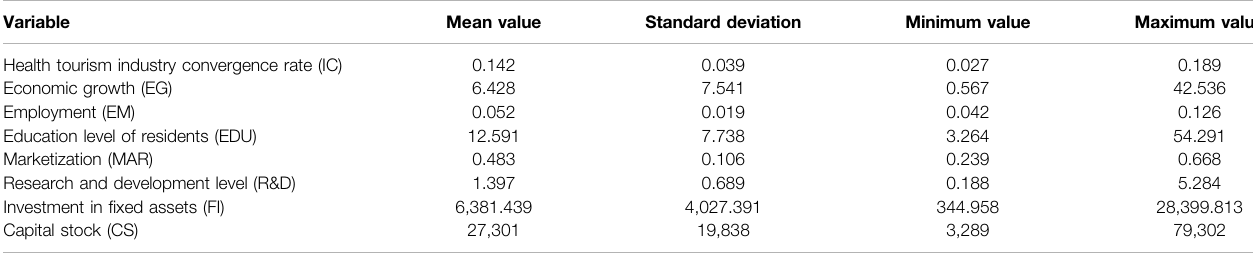
TABLE 5 | Descriptive statistical of variables. Variable